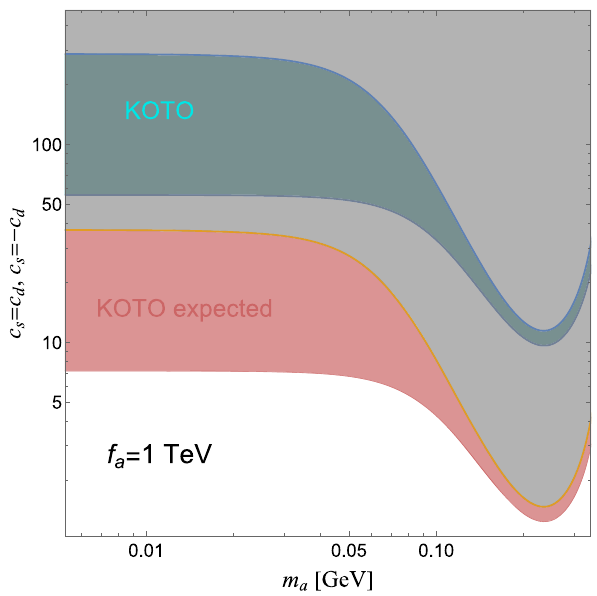
Fig. 4 Excluded parameter regions derived from tree-level channels for charged (left) and neutral (right) K → π a decays. In the left plot limits are derived from NA62 (pink) and E949 (cyan) experiments. In the right plot, bounds are obtained from present (cyan) and expected (pink) KOTO